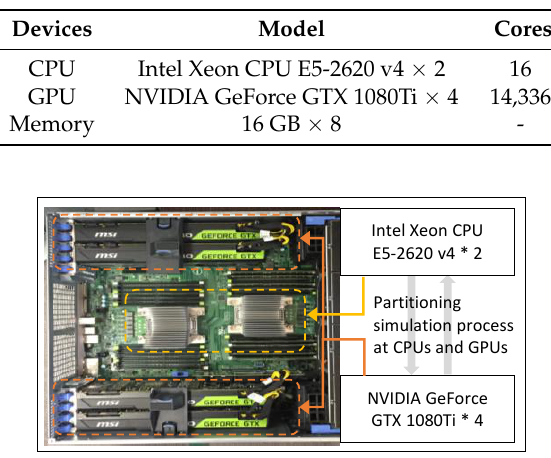
Table 1. Hardware specifications.